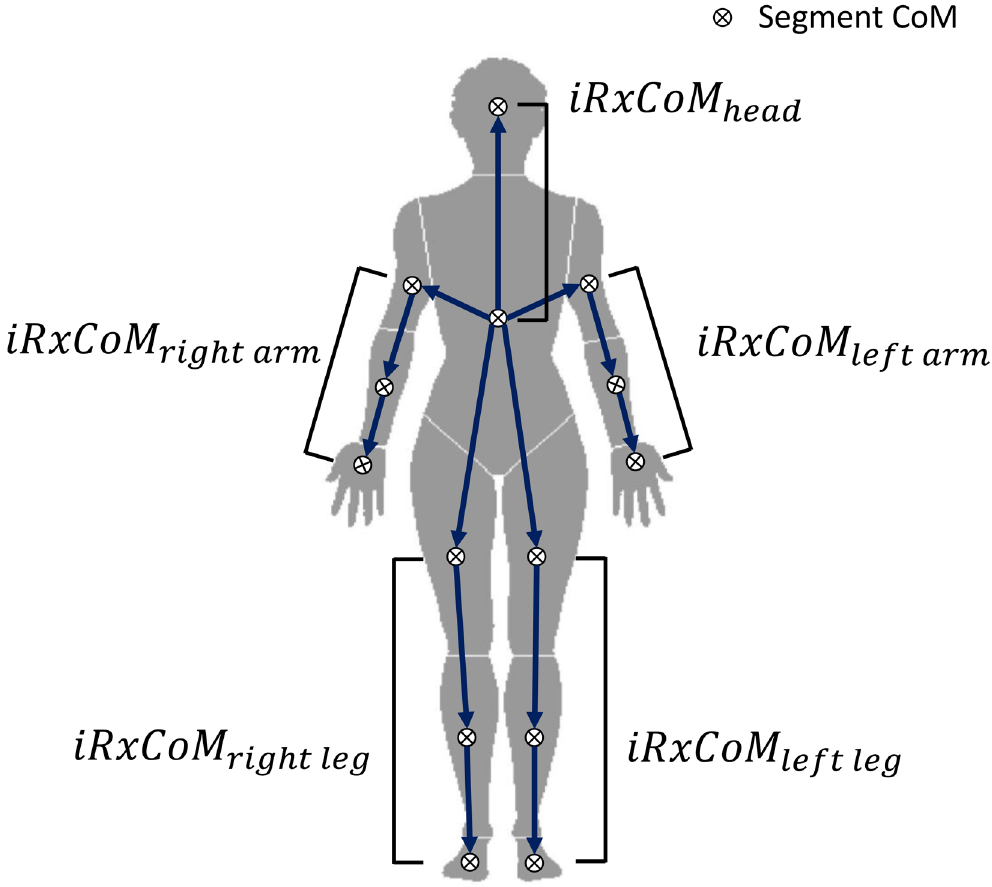
Figure 2. Relative individual segmental extrapolated center of mass ( iRx CoM ) in human skeletal system. Five body parts (right and left arms, right and left legs, and head) from the trunk segment were separated. In each body part, iRx CoM was calculated as individual segmental CoM positions based on the proximal segmental CoM. Drawn using Adobe Illustrator CS6 (www.adobe .com) and Microsoft Office 2016 (www.micro